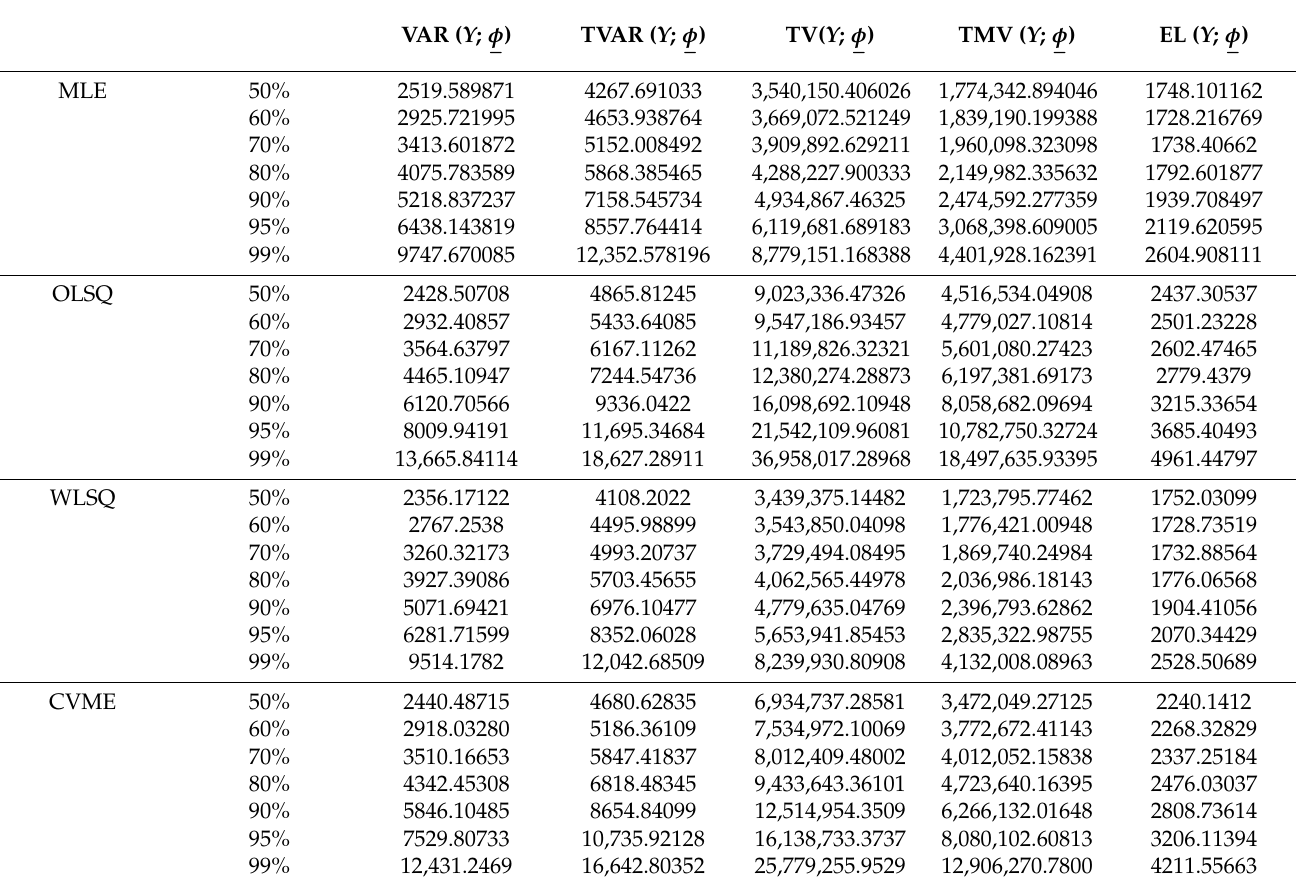
Table 11. The KRIs for the GRR-RW under insurance claims